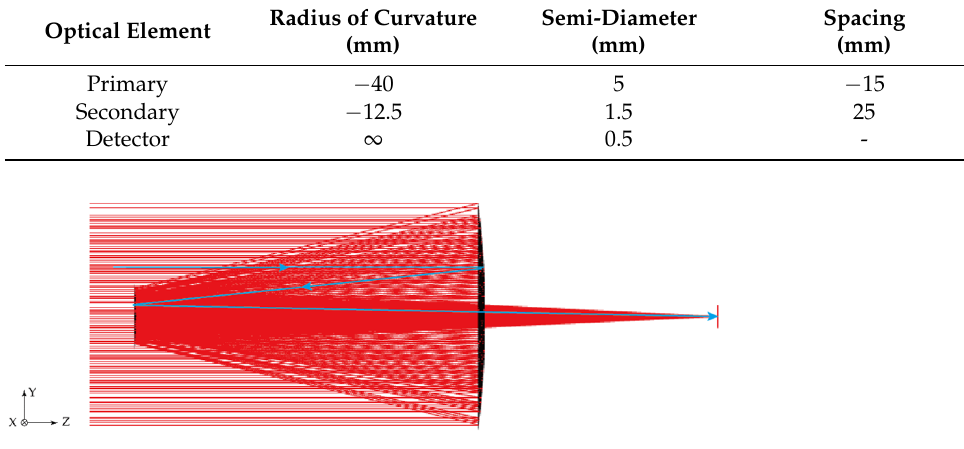
Figure 7. The optical path of the specular beam of a typical Cassegrain telescope . Table 2. Optical configuration of a typical Cassegrain system.